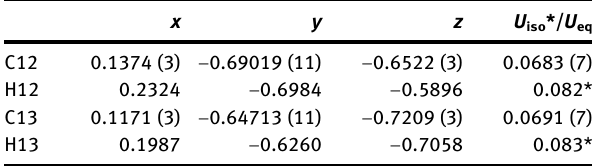
Table  : Fractional atomic coordinates and isotropic or equivalent isotropic displacement parameters (Å 